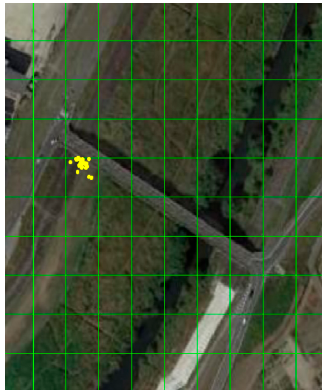
Figure 1. The image is divided into 10×10 non-overlapping grid cells, where the feature points in a grid cell are marked in yellow.